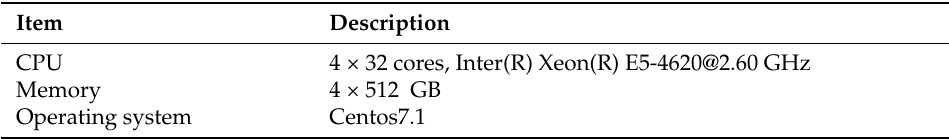
Table 1. Experimental environment.